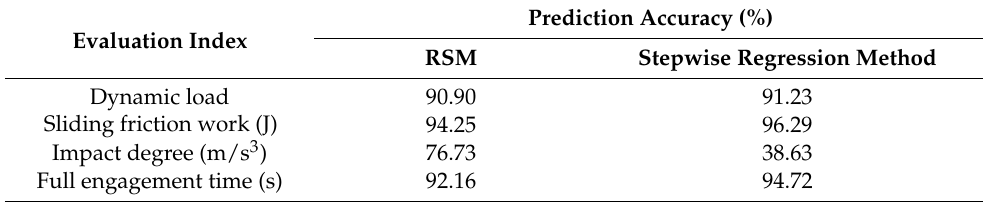
Table 9. Comparison of prediction accuracy between the RSM models and the stepwise models.